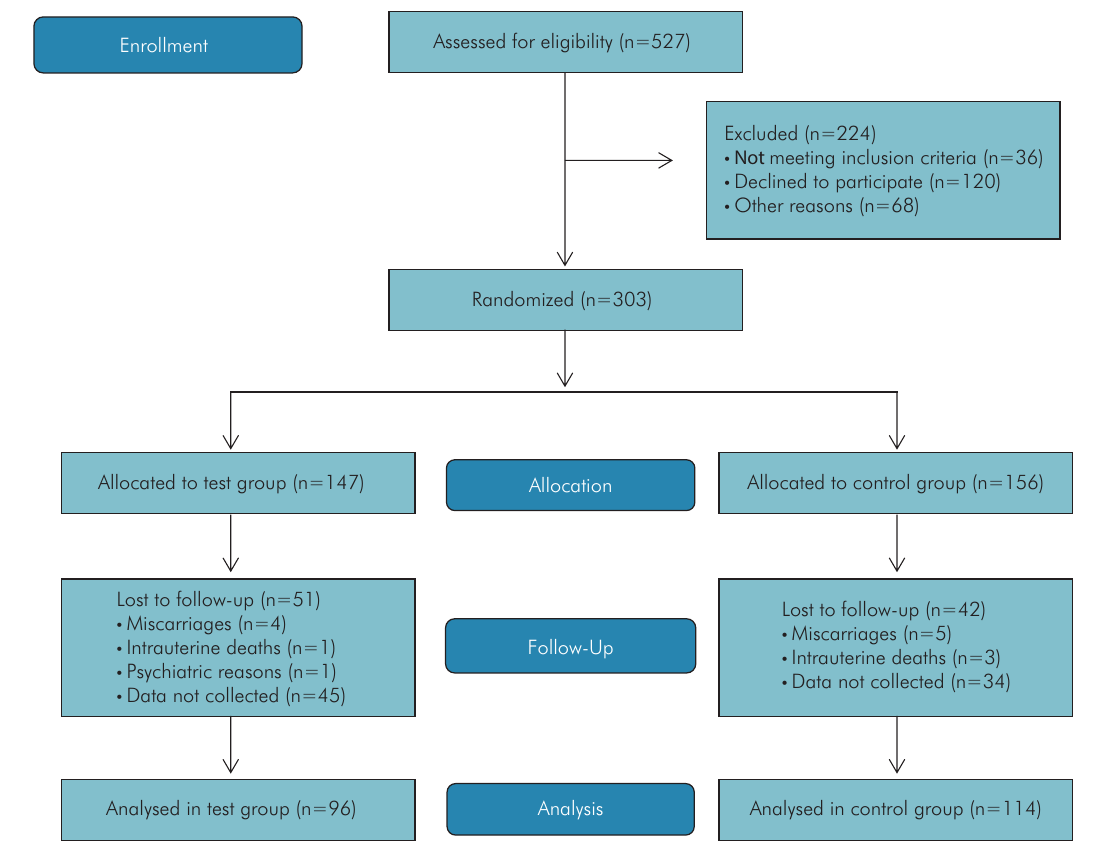
Figure 2. Flow chart of the